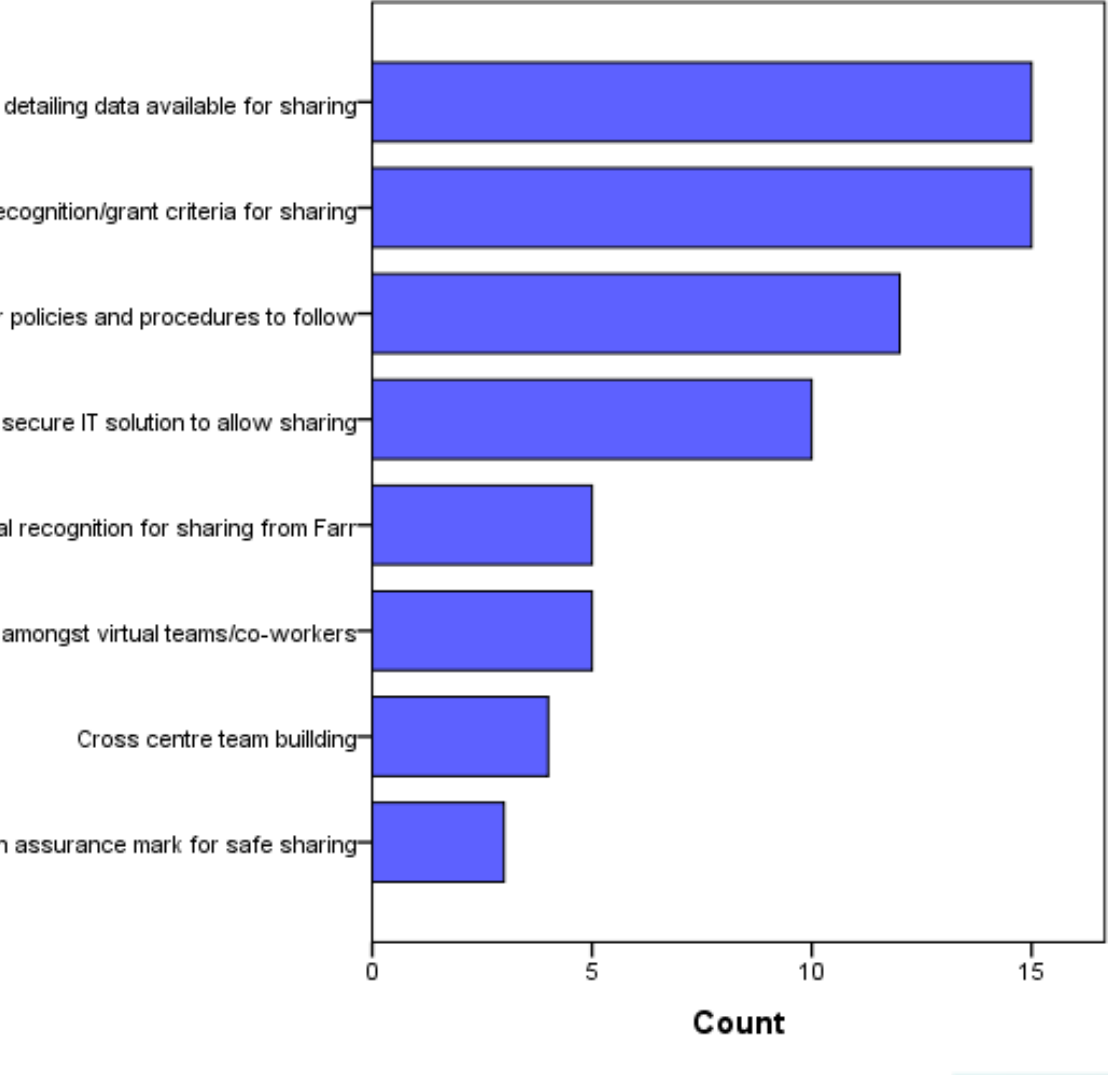
Figure 2: Ranked solutions that would most encourage cross-centre